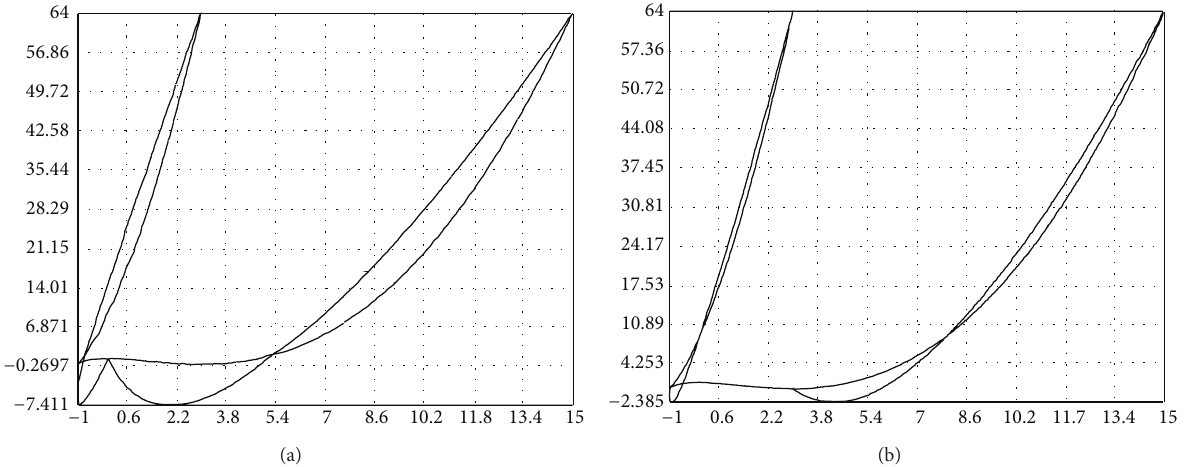
Figure 3: Approximation of vector-function g (𝑡) = (𝑡(𝑡 − 2), (𝑡 − 1) 2 (𝑡 + 1) 2 ) by fractal interpolation function g ⋆ with three (a) and four (b) points of interpolation